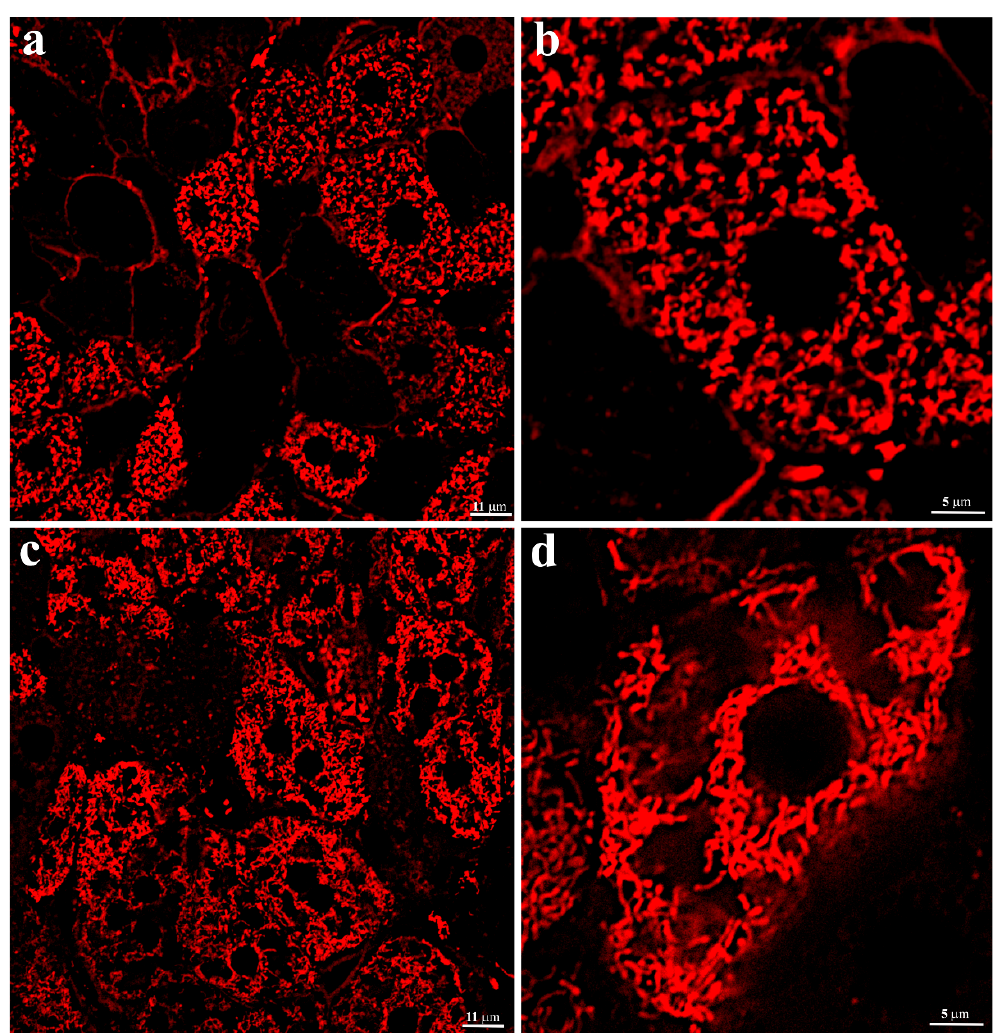
Figure 2. Evaluation of the transmembrane potential and structure of mitochondria in the vital liver tissue sections. Confocal microscopy of a vital liver tissue section stained with TMRE: ( a ) 2-months- old C57BL/6 mice, overview; ( b ) 2-months-old C57BL/6 mice, higher magnification; ( c ) 3-years-old